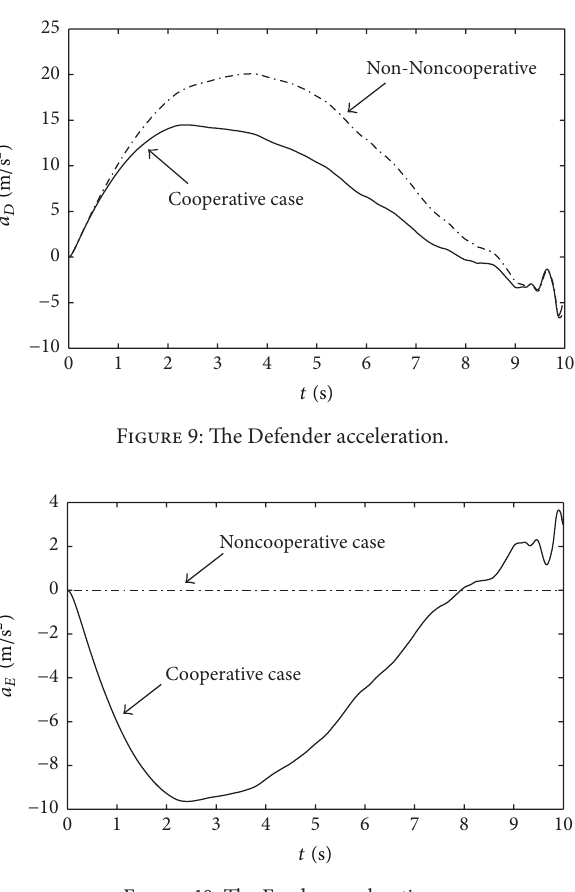
Figure 10: The Evader acceleration. Table 3: Simulation parameters of HP guidance pursuer case.